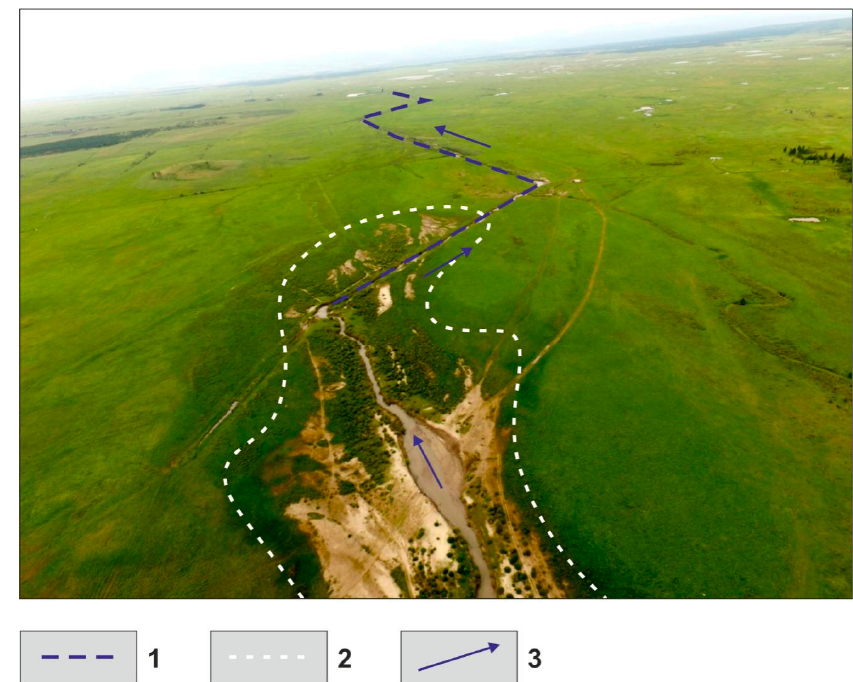
Figure 13. Zone of accumulation of suspended load on the Kyngarga river where it enters the dike. Images were taken on July 12, 2017, from the Phantom 3 quadcopter, at 234 m (51°51’5.36’’N, 102°27’20.09’’E). 1: boundary of accumulation of suspended load; 2: dike; 3: direction of the river.